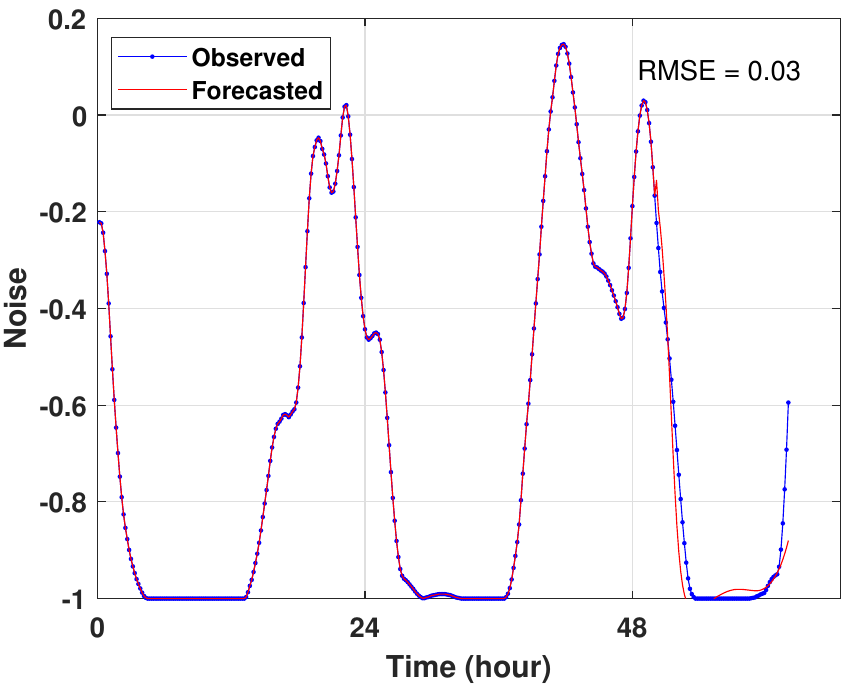
Figure 13. Noise forecasting by GA-LSTM.